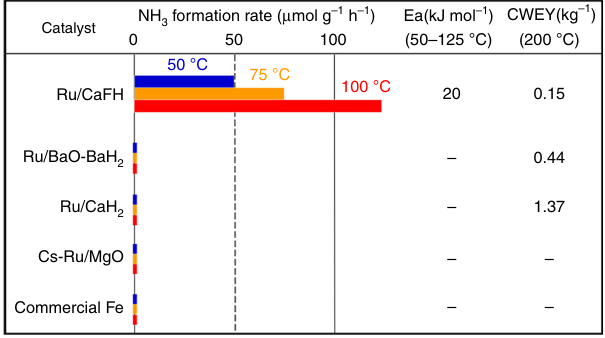
Fig. 3 Catalytic performance. The amounts of loaded Ru on Ru/CaFH, Ru/ BaO – BaH 2 , Ru/CaH 2 , and Cs – Ru/MgO were 12, 10, 10, and 10wt%, respectively. The catalytic activities of these catalysts at ca. 300°C reached the maxima with each Ru loading. The rates of ammonia formation for Ru/ CaFH at 50, 75, 100, and 125 °C were 50, 75, 120, and 190 μ mol g − 1 h − 1 , respectively. CWEYs were estimated from the rates of ammonia formation at each reaction temperature. It was con fi rmed that the rates of ammonia formation ( μ molh − 1 ) for Ru/CaFH, Ru/BaO – BaH 2 , and Ru/CaH 2 increased in direct ratio to catalyst weight (0.05 – 5.00